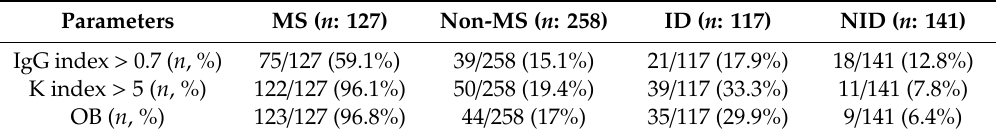
Figure 1. Kappa (K) ( left ) and immunoglobulin G (IgG) ( right ) indexes in patients with multiple sclerosis (MS) in group 1, inflammatory diseases (ID) in group 2 and non-inflammatory diseases (NID) in group 3. Table 1. Prevalence of elevated K and IgG indexes and oligoclonal bands (OB) types 2 and 3 among patients with multiple sclerosis (MS), inflammatory diseases (ID) and non-inflammatory diseases (NID).